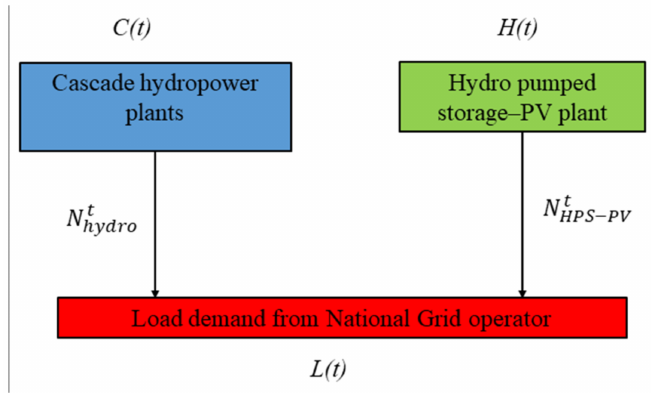
Figure 1. The schematic diagram for the optimization